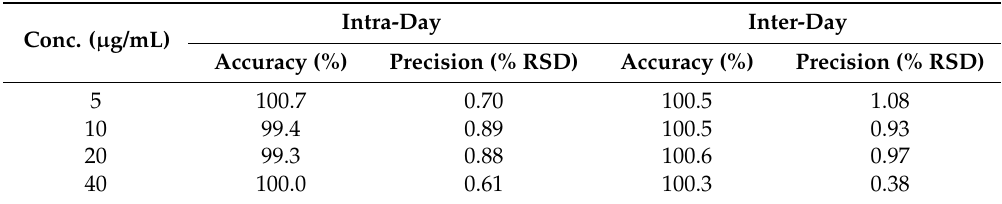
Table 2. Accuracy and precision data of the HPLC method obtained from intra- and inter-day studies. Concentrations shown in µ g/mL. RSD = relative standard deviation.